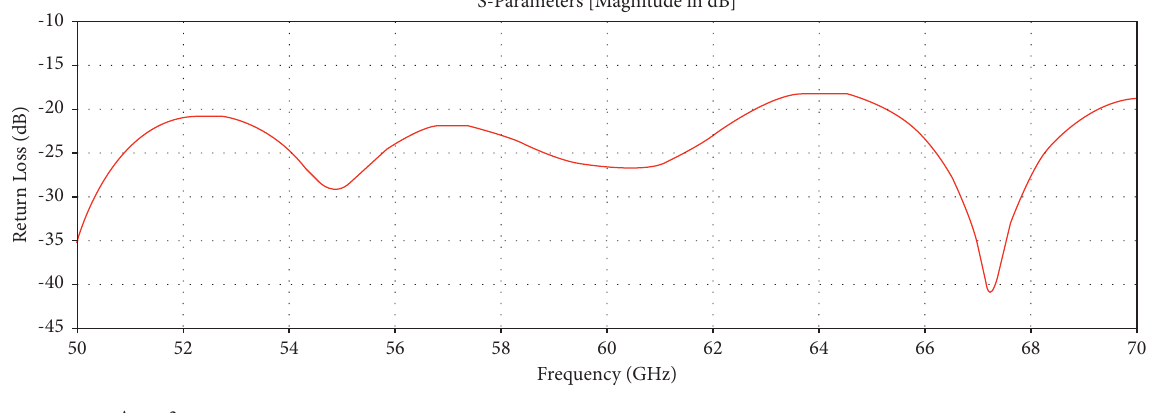
Figure 5: Simulated free-space return loss of Array 3.